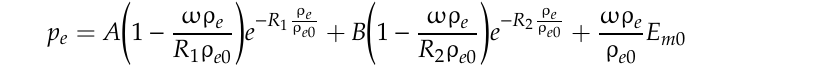
Table 5. Jones–Wilkins–Lee (JWL) model parameters of the TNT charge [39].